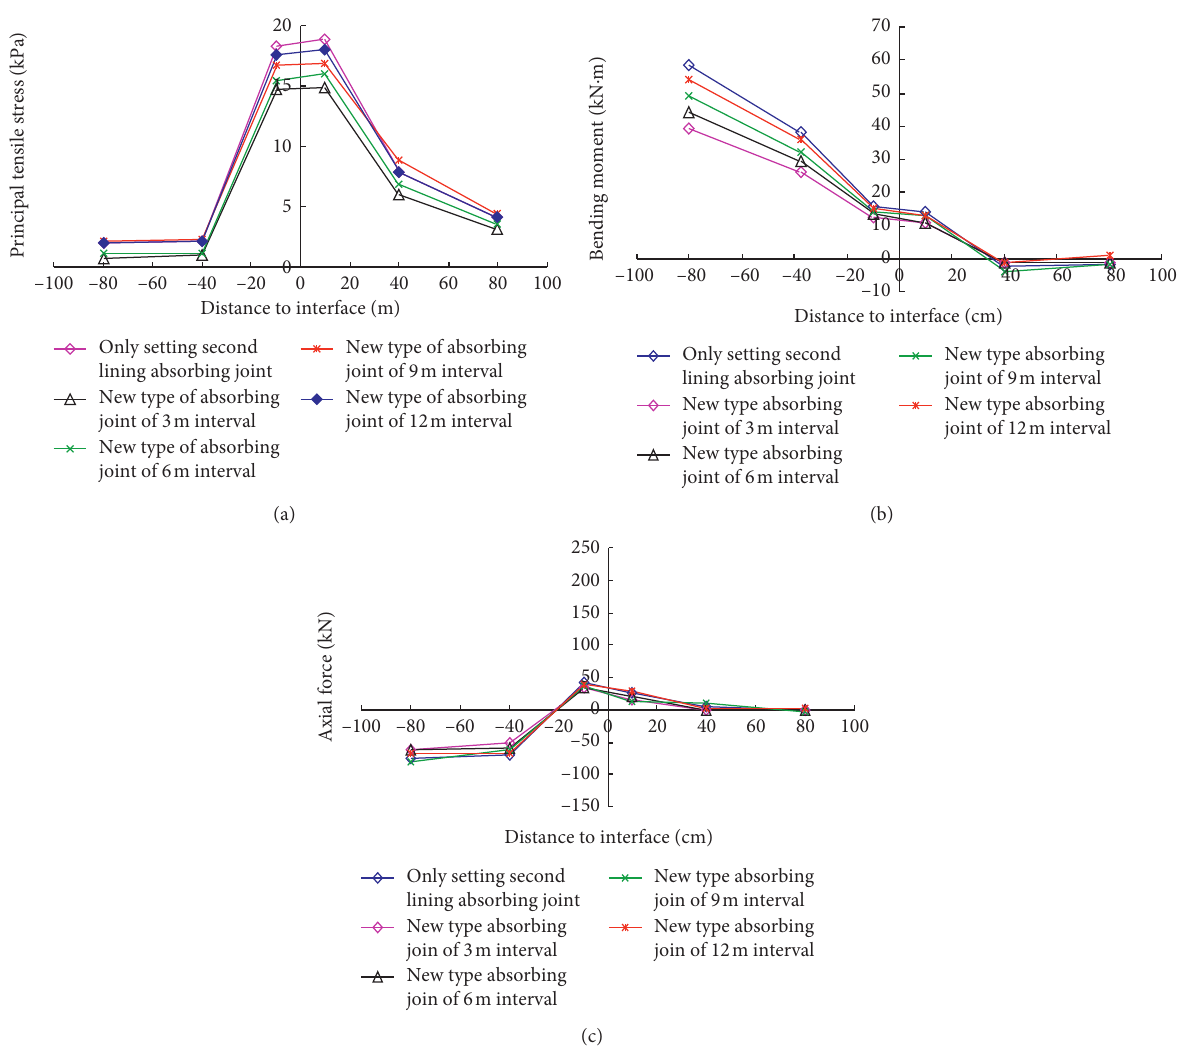
Figure 16: Internal force of tunnel vault at each monitoring section. (a) Principal tensile stress of vault. (b) Bending moment of vault. (c) Axial force of